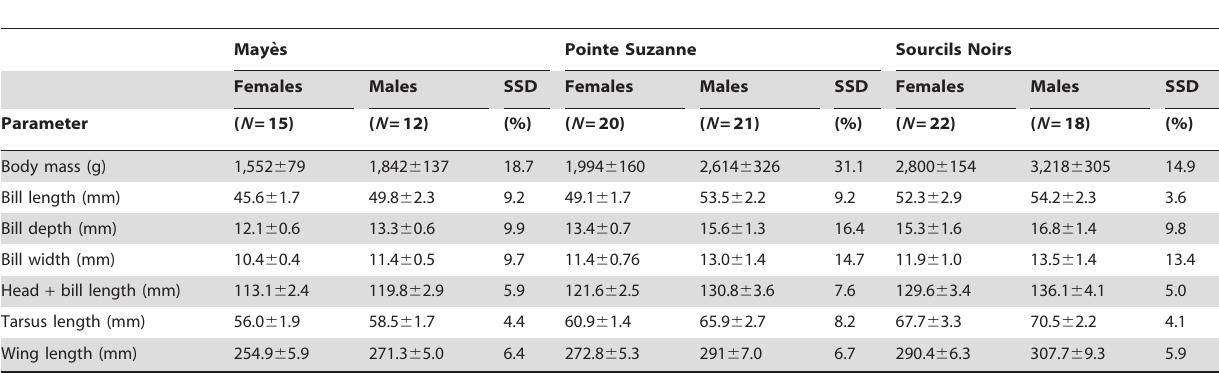
Table 1. Morphological differences between sexes and colonies of Kerguelen Shags. SSD is expressed as the sexual difference in the body trait divided by the female body trait.